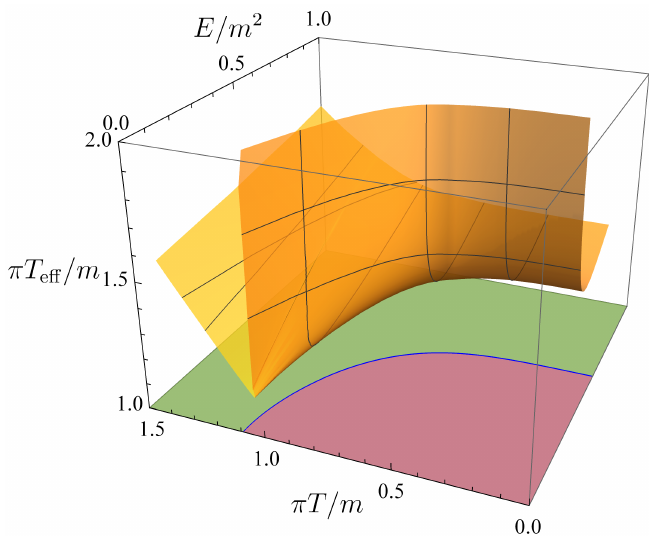
Figure 5 . The plot of πT eff /m with respect to E/m 2 and πT/m within 0 < E/m 2 < 1 and 0 < πT/m < 1 . 5 . The purple and green regions and solid blue curve on the bottom denote the Minkowski embedding, black hole, and critical embeddings,